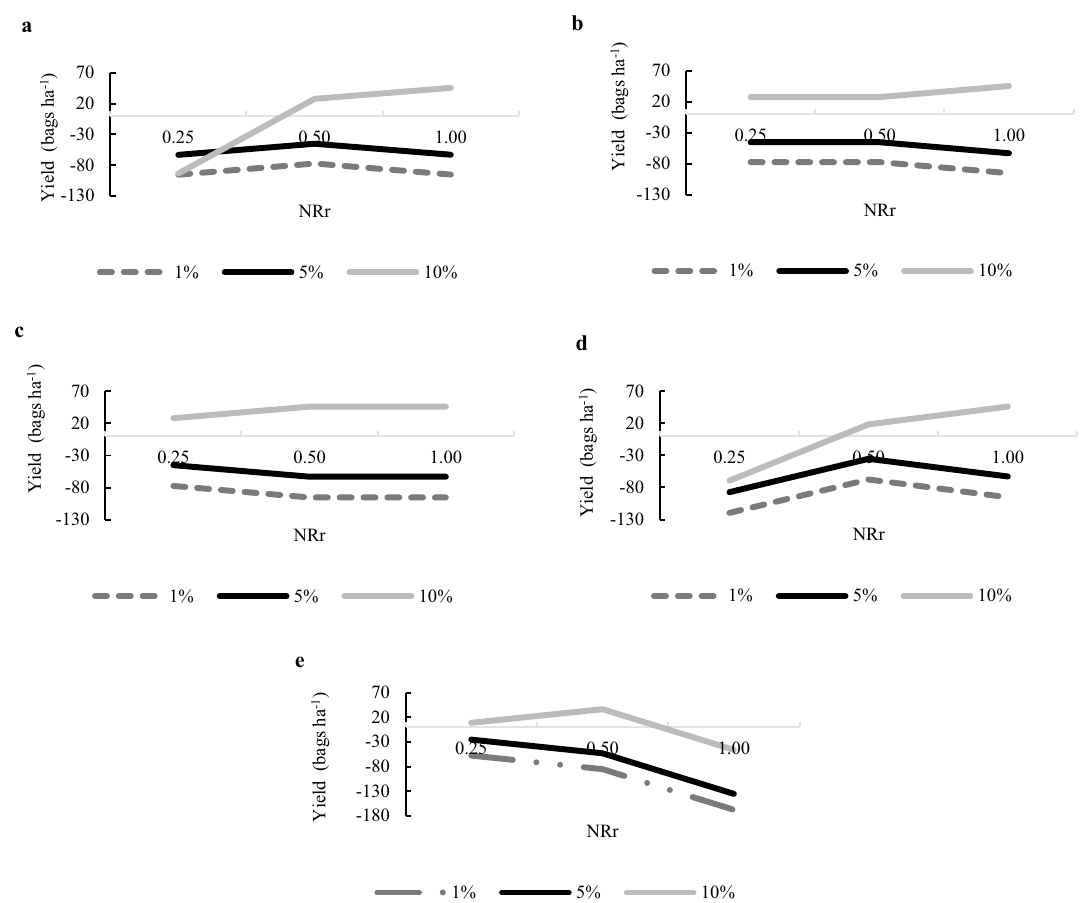
Figure 3. Net yield response [Net d(Y)] as a function of the nutritional diagnosis of B obtained by the DRIS method adopting the criteria of selecting all bivariate relationships—DrisAll ( a ), using the criterion Ratio of Variances—DrisVar ( b ), using the F test—DrisFtest ( c ) or using the logarithmic transformation—DrisLog ( d ) and compositional nutrient diagnosis—CND ( e ). using 0.25; 0.50 and 1.0 for nutrient responsiveness range (NRr) and 1%, 5% and 10% for yield response